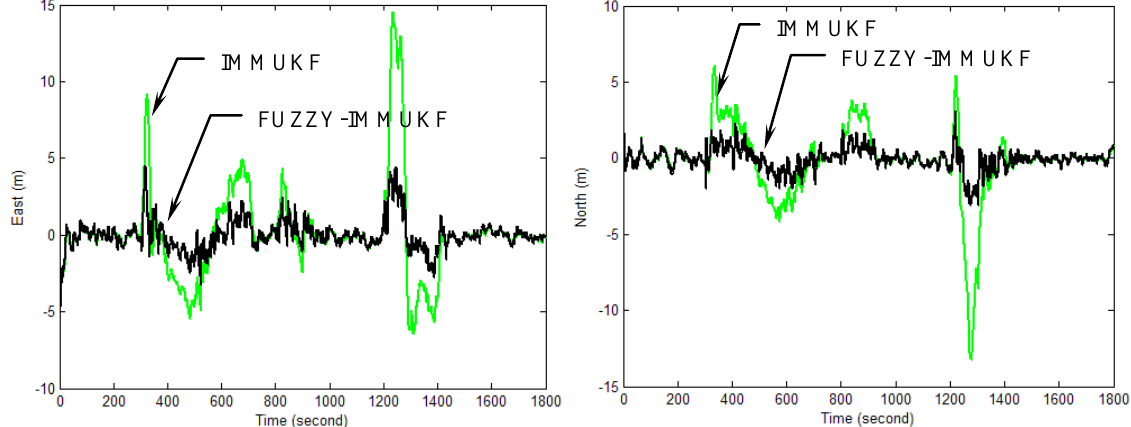
Figure 12. Comparison of the navigation accuracy for IMMUKF and FUZZY-IMMUKF.